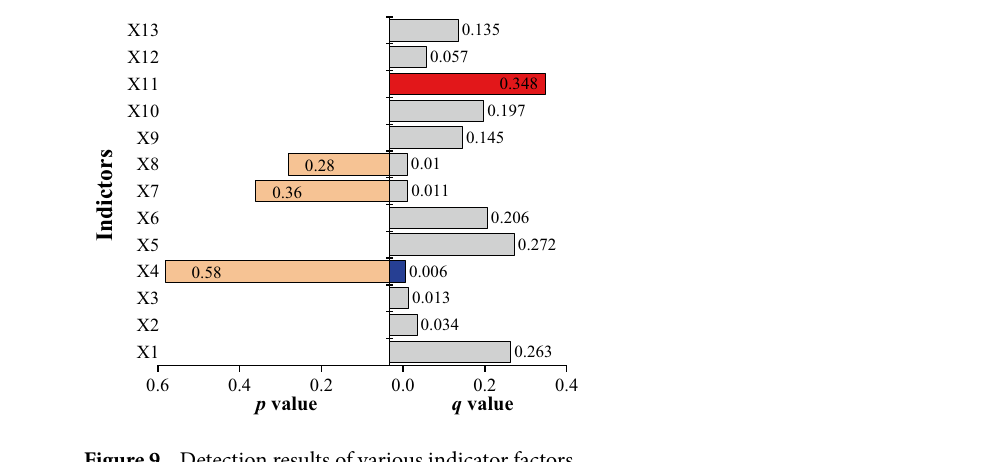
Figure 9. Detection results of various indicator factors.